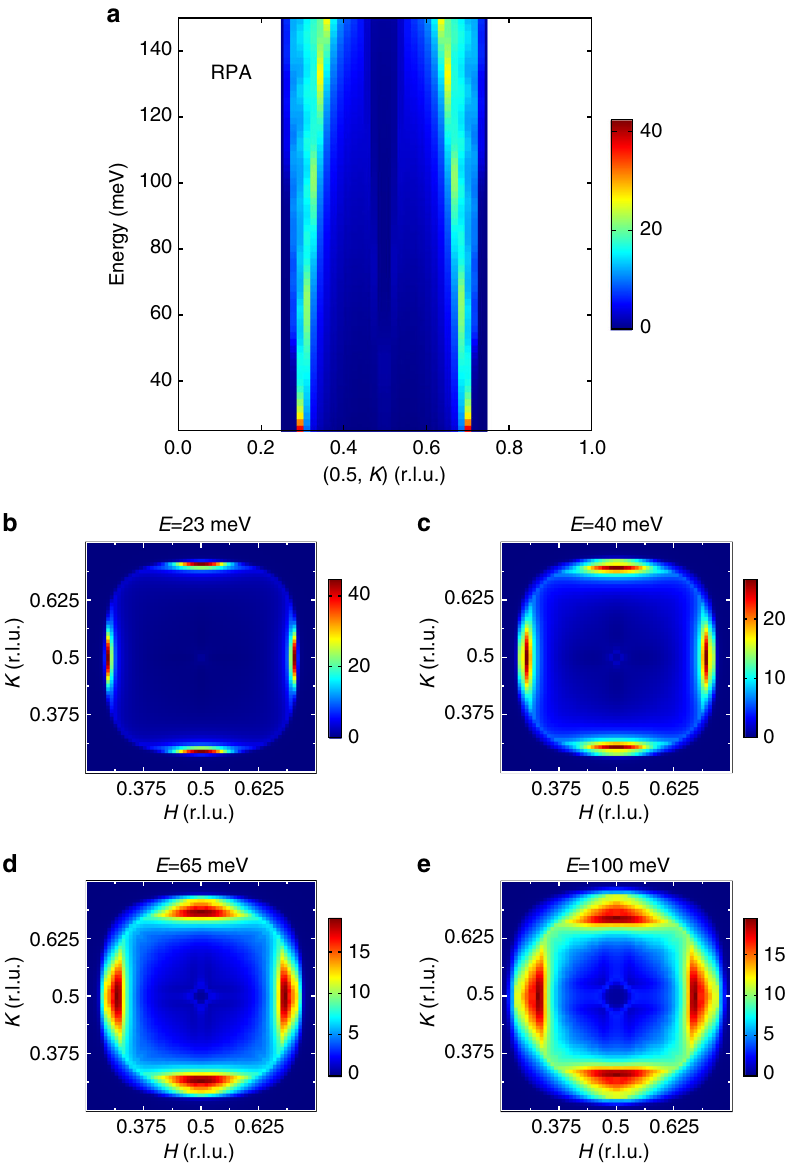
Fig. 5 Calculated dispersion of the spin excitations of Li 0.8 Fe 0.2 ODFeSe in the superconducting state. The calculation was done using a BCS/RPA approach described in the main text. a Dispersion of the spin excitations. b – e Momentum structure of the spin excitations at indicated energies. The color bars indicate intensity in arbitrary